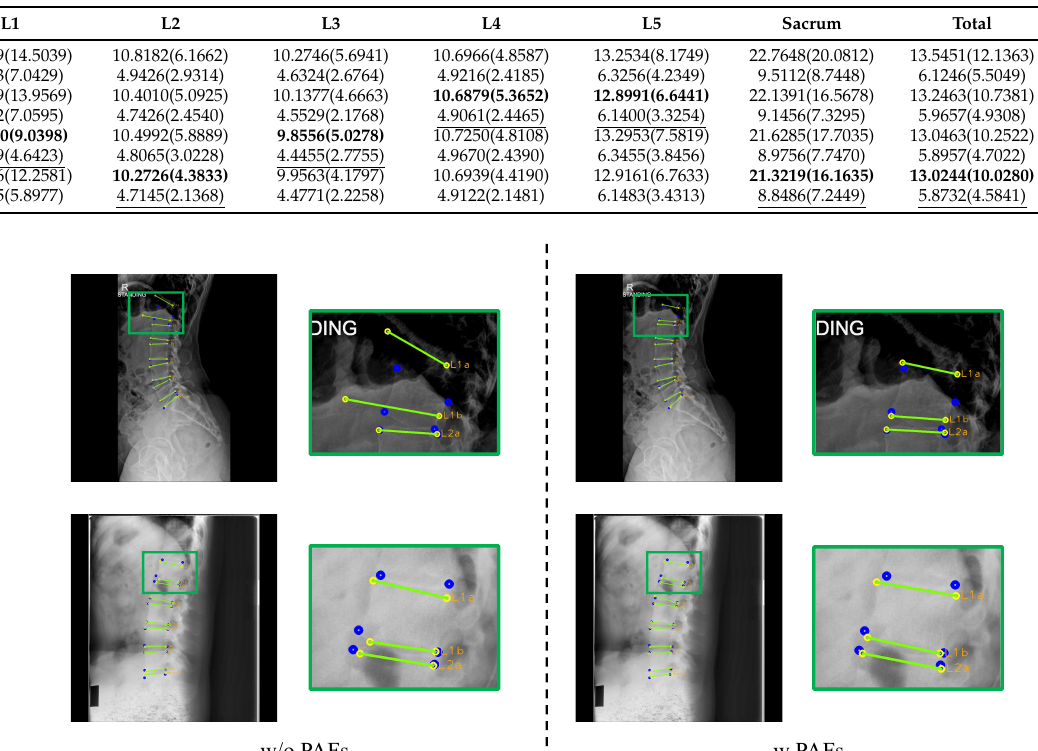
Figure 15. Results of landmark detection with or without PAFs. The blue circles represent the ground truth, while yellow circles with labels represent predicted results, and the green lines represent the line connecting the predicted landmarks of an